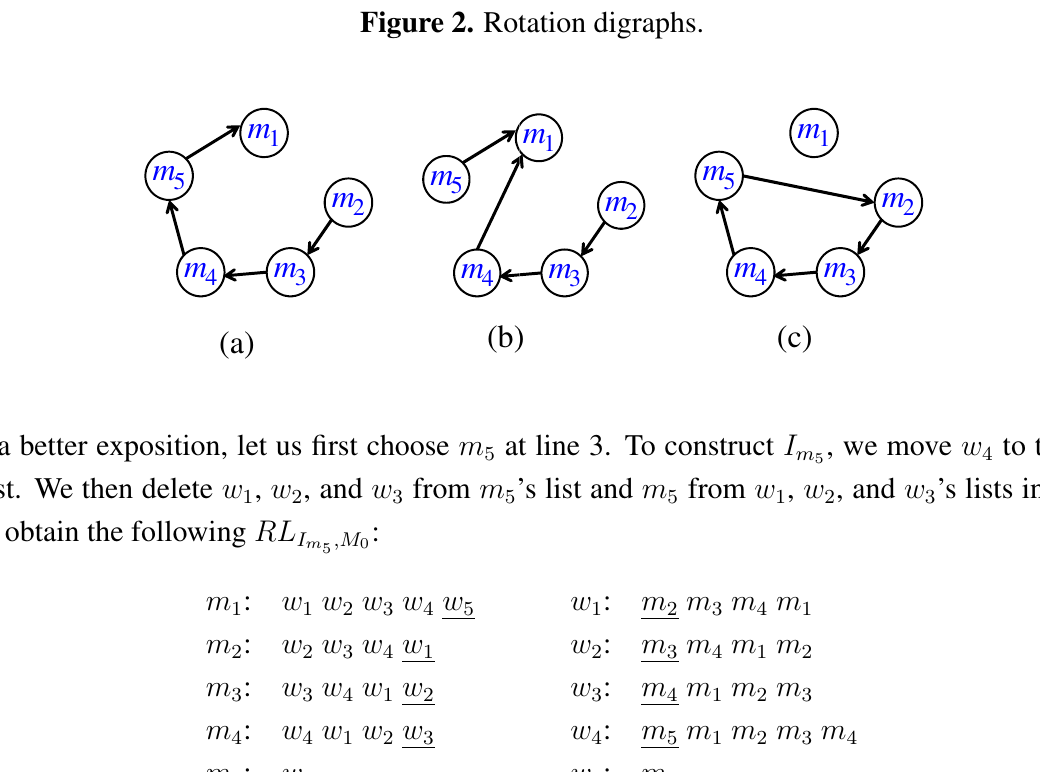
Figure 2. Rotation